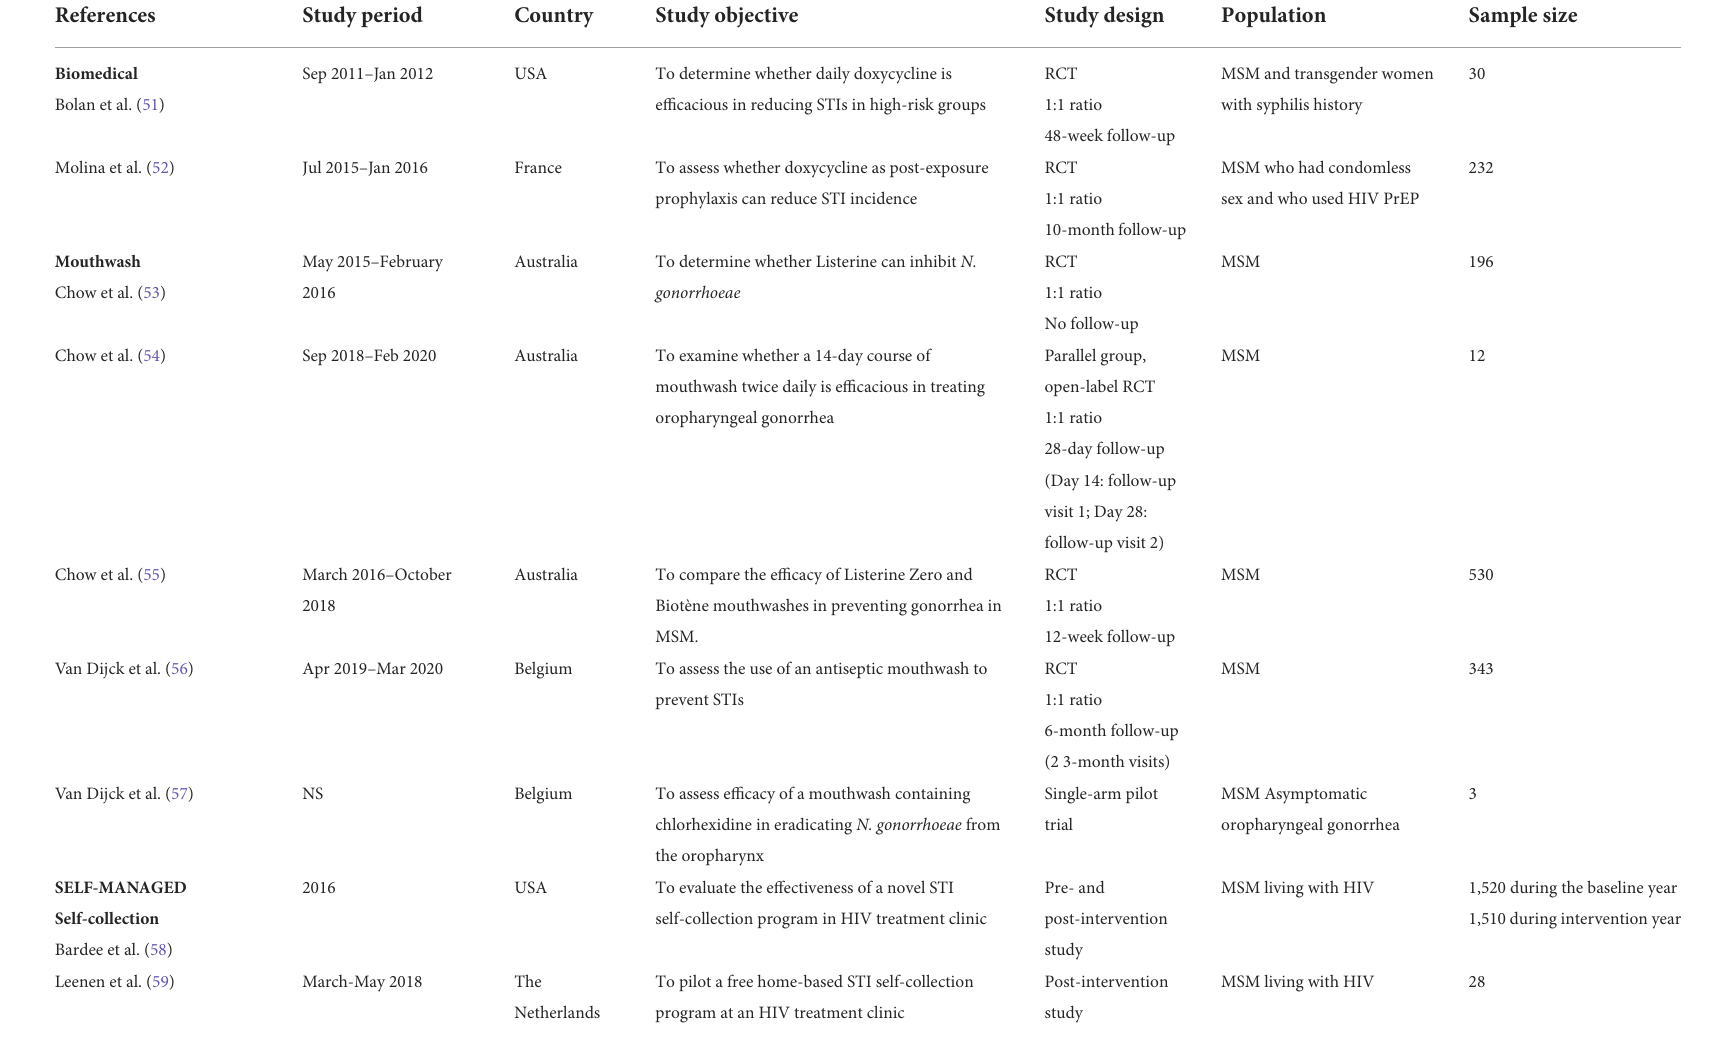
TABLE 1 Characteristics of the included studies of non-conventional interventions for gonorrhea and/or syphilis prevention in